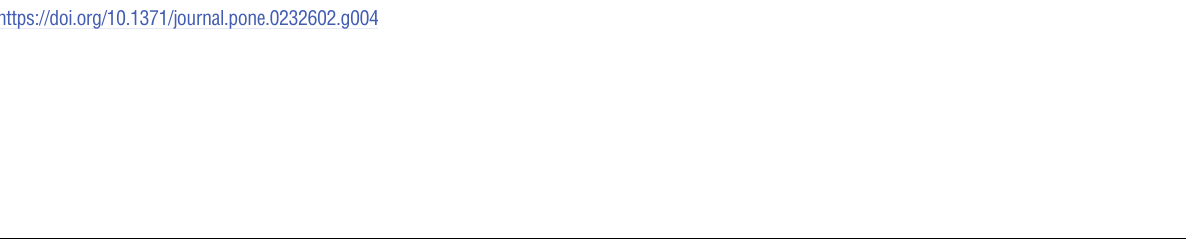
PLOS ONE | https://doi.org/10.1371/journal.pone.0232602 May 7,